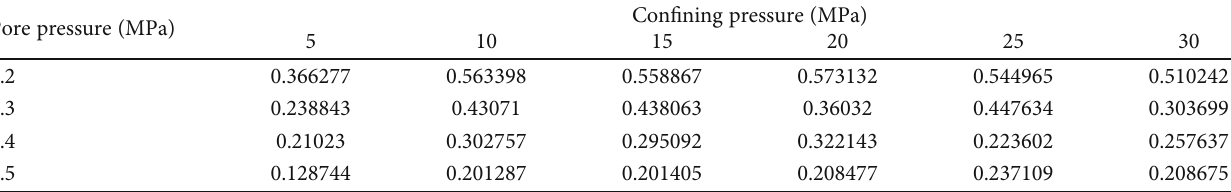
Table 5: Contribution rates of the gas slippage e ff ects (300 ° C).